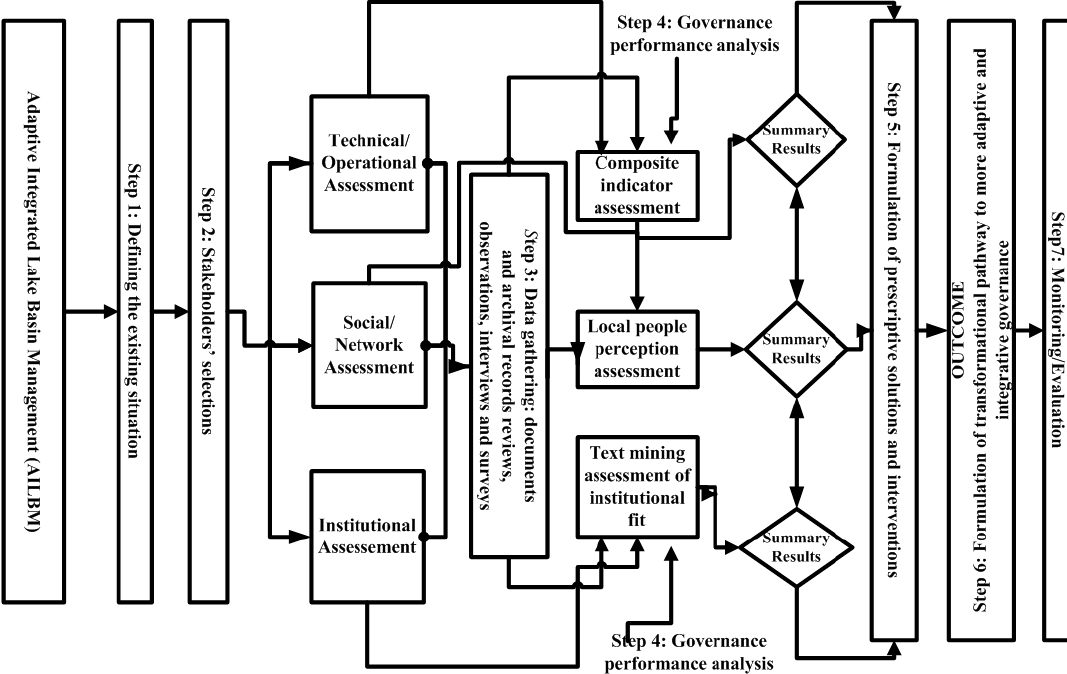
Figure 2. Multidimensional AILBM governance performance assessment process.